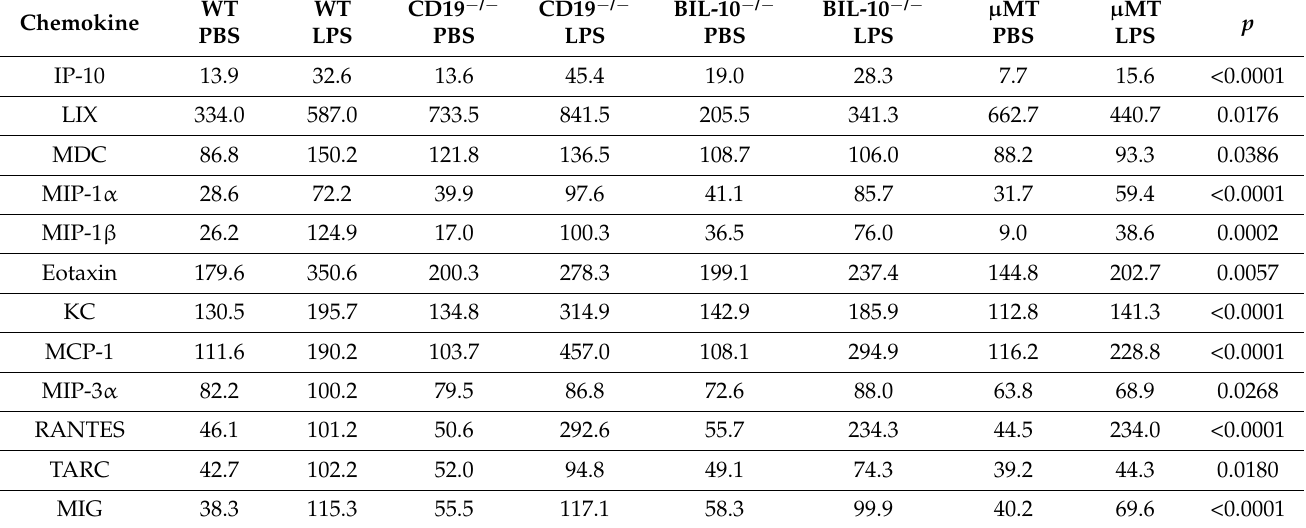
Table 1. Chemokine levels (in pg/mL) in serum of PBS- and LPS-treated WT, CD19 −/− , BIL-10 −/− and µMT mice. Chemokines were measured by flow cytometry. Presented are the mean values; the p values were calculated by One-way ANOVA or Kruskal – Wallis test after Shapiro – Wilk test.